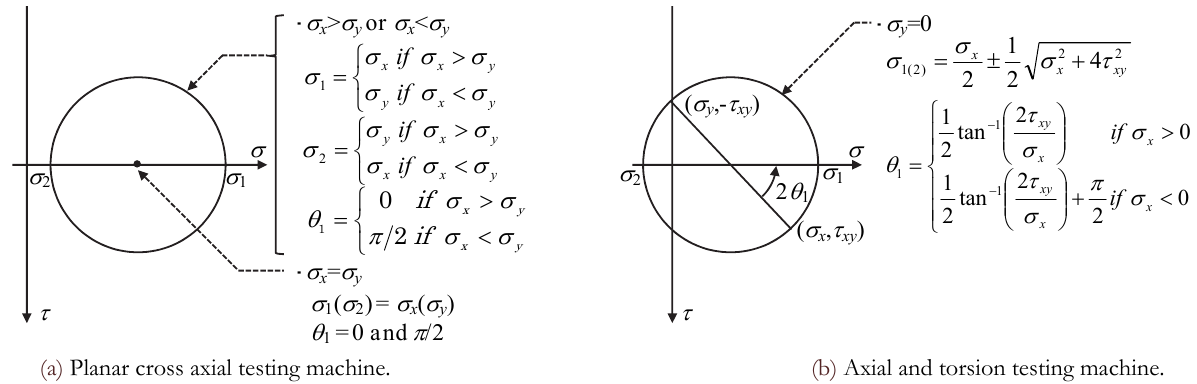
Figure 1: Stress states under Mohr’s stress circle generated with each testing